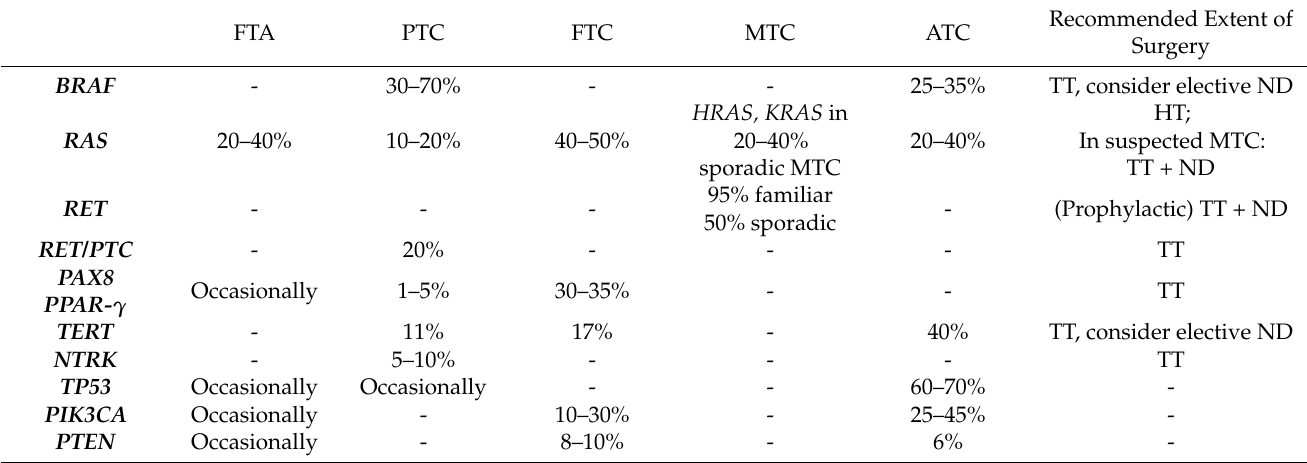
Table 1. The most common mutations and their detection in thyroid tumors (FTA—follicular